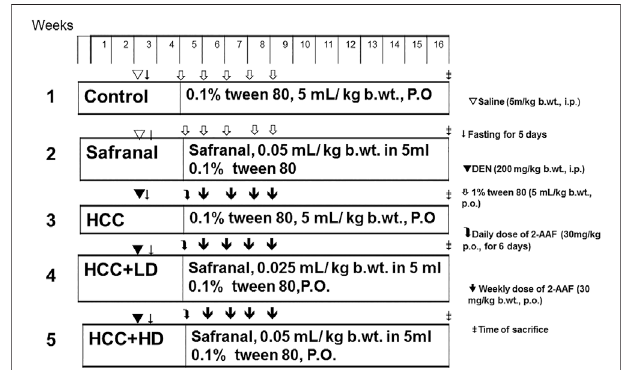
FIGURE 1 | Schematic diagram showing the experimental design to induce and treat liver cancer in vivo